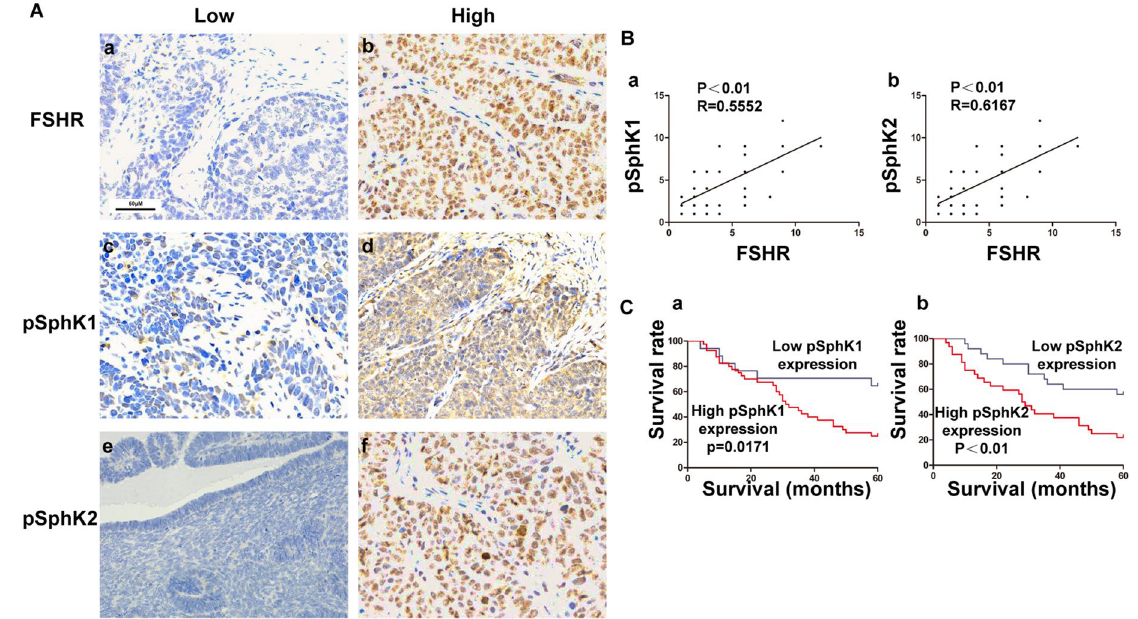
Figure 1. EOC tissues showed elevated expression of phosphor-SphK1 and phosphor-SphK2. ( A ) Immunohistochemical staining for pSphk1, pSphk2 and FSHR in EOC tissues. (a) Low FSHR expression; (b) high FSHR expression; (c) low phosphor-Sphk1 expression; (d) high phosphor-Sphk1 expression high phosphor-Sphk2 expression; (e) low phosphor-Sphk2 expression; (f) high phosphor-Sphk2 expression. Magnification,200 × (a–f). ( B ) The relationship between expression of pSphk1 (pSphk2) and FSHR in epithelial ovarian cancer tissues. We used Pearson’s correlation coefficient to detect the correlation between the variables of pSphk1and FSHR (a) (r = 0.5552, P < 0.01), pSphk2 and FSHR (b) (r = 0.6167, P <01) as indicated by the regression line. ( C ) Kaplan–Meier survival analysis of the overall survival of epithelial ovarian cancer patients. (a) High phosphor-Sphk1 expression. (b) High phosphor-Sphk2 expression. P < 0.05 based on the log-rank